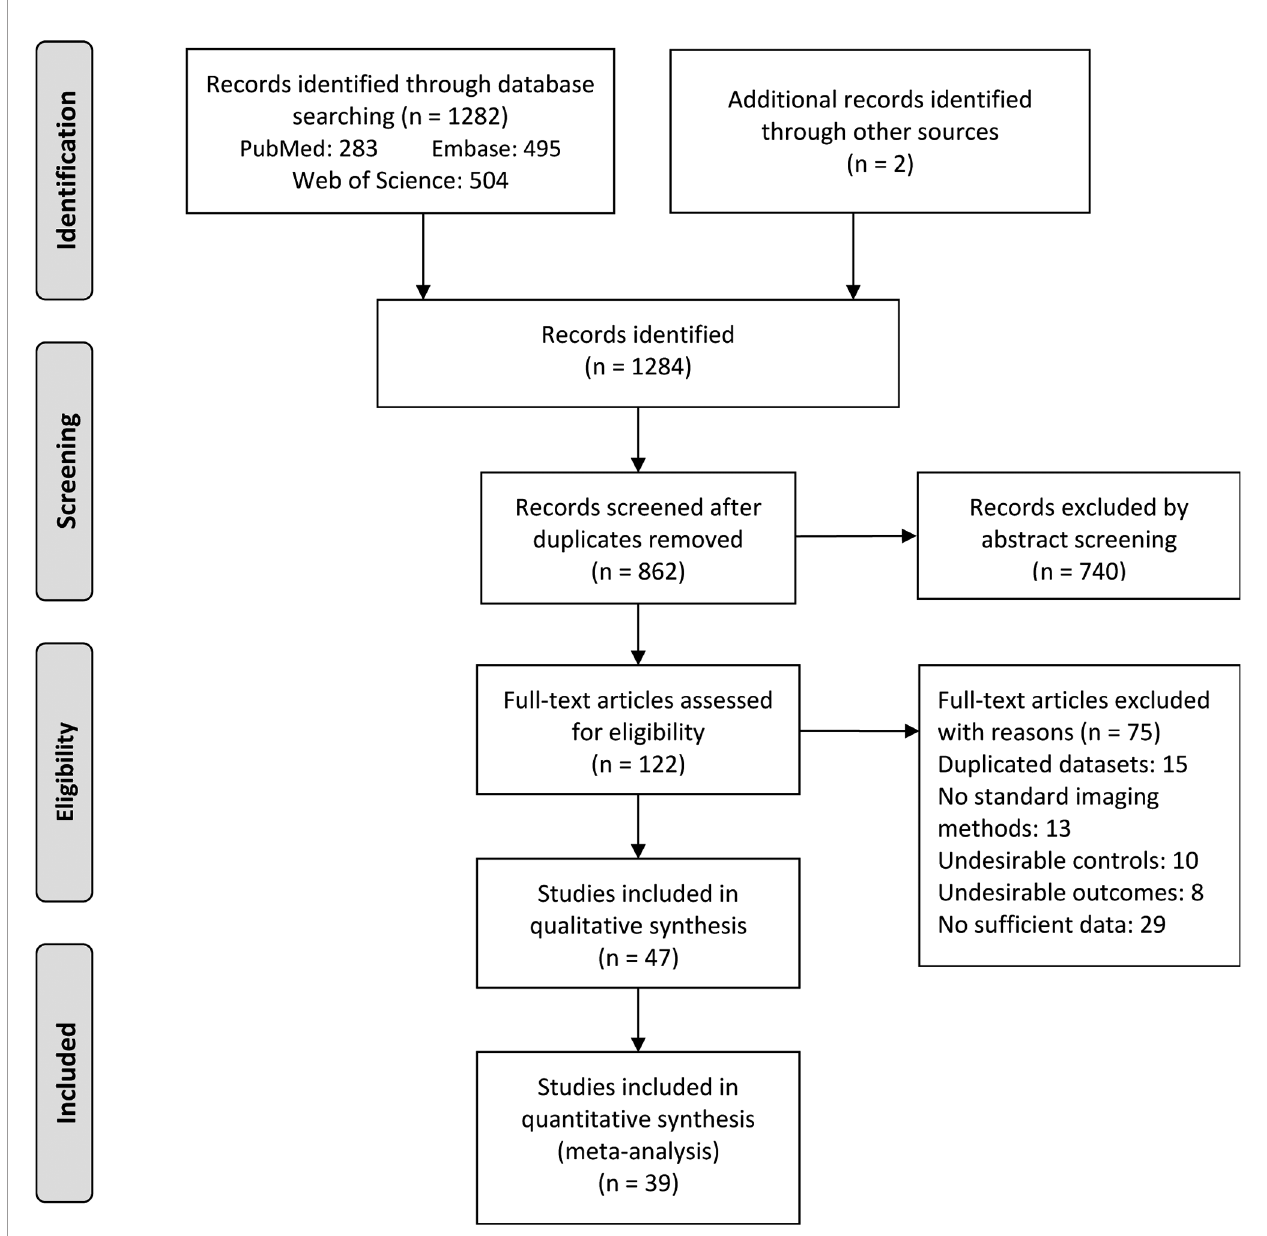
FIGURE 1 | PRISMA fl ow diagram for study selection. From: Moher D, Liberati A, Tetzlaff J, Altman DG, The PRISMA Group (2009). Preferred Reporting Items for Systematic Reviews and Meta-Analyses: The PRISMA Statement. PLoS Med 6(7): e1000097.